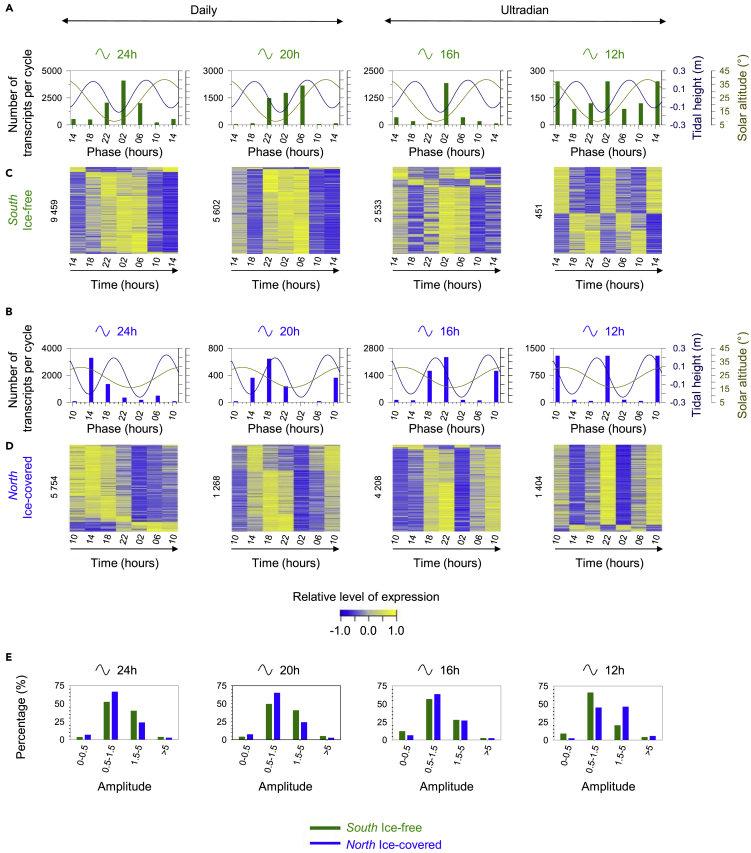
Rhythmic patterns at South (74.5°N, ice-free) and North (82.5°N, ice-covered) stations and coincidence with environmental cycles(A and B) Phase distributions of daily (24h and 20h period lengths, adj-p < 0.001) and ultradian transcripts (16h and 12h period lengths, adj-p < 0.001) at South (A) and North (B), according to RAIN algorithm, expressed as the number of transcripts per cycle at each sampling time (hours). Solar altitude above the horizon (°, dark yellow) and tidal height (m, dark blue) cycles over the sampling times at each station were plotted in the background.(C and D). Heatmaps of daily (24h and 20h period lengths, adj-p < 0.001) and ultradian transcripts (16h and 12h period lengths, adj-p < 0.001) at South (C) and North (D), showing the relative level of expression of rhythmic transcripts along the sampling times (hours), normalized to the median of each transcript. Lowest levels of expression were in blue, highest levels of expression were in yellow, and the transcripts were ordered by phases. The numbers of transcripts for each period length and station were indicated on the left of heatmaps. The time was indicated in hours, local time (UTC +2).(E) Amplitude ranges distribution of daily (24h and 20h period lengths, adj-p < 0.001) and ultradian transcripts (16h and 12h period lengths, adj-p < 0.001) at South (green) and North (blue), expressed as percentage of rhythmic transcripts per period length and station. An amplitude of 0.5 means that the difference between the minimal and the maximal levels of expression is equal to 0.5 times the minimal level.